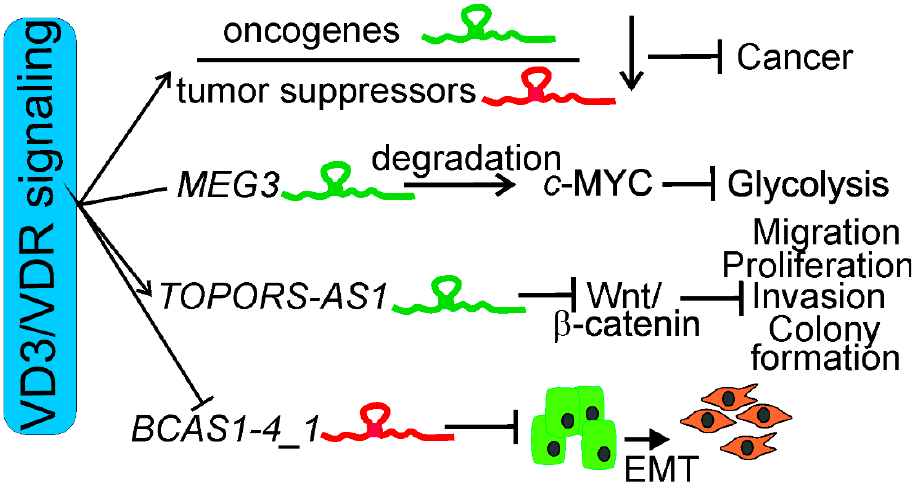
Figure 3. Different mechanisms of anticancer action of vitamin D3 (VD3) and its receptor, VDR, supported by long noncoding RNAs (lncRNAs). Vitamin D3 and VDR may decrease the expression of oncogenic lncRNAs and/or increase the expression of their tumor-suppressing counterparts. Vitamin D may activate lncRNAs that degrade BHLH transcription factor, MYC proto-oncogene (c-Myc), causing inhibition of glycolysis in cancer cells, as shown for the maternally expressed gene 3 ( MEG3 ) lncRNA and the colorectal cancer cell line. Vitamin D3/VDR may stimulate a tumor-suppressing lncRNA to disrupt Wnt/ β -catenin signaling, resulting in inhibition of migration, proliferation, invasion, and colony formation of cancer cells, as shown for TOPORS antisense RNA 1 ( TOPORS-AS1 ). 1,25(OH)2D may inhibit lncBCAS1-4_1 ( BCAS1-4_1 ), causing inhibition of epithelial/mesenchymal transition (EMT), an important effect in invasion and metastasis.